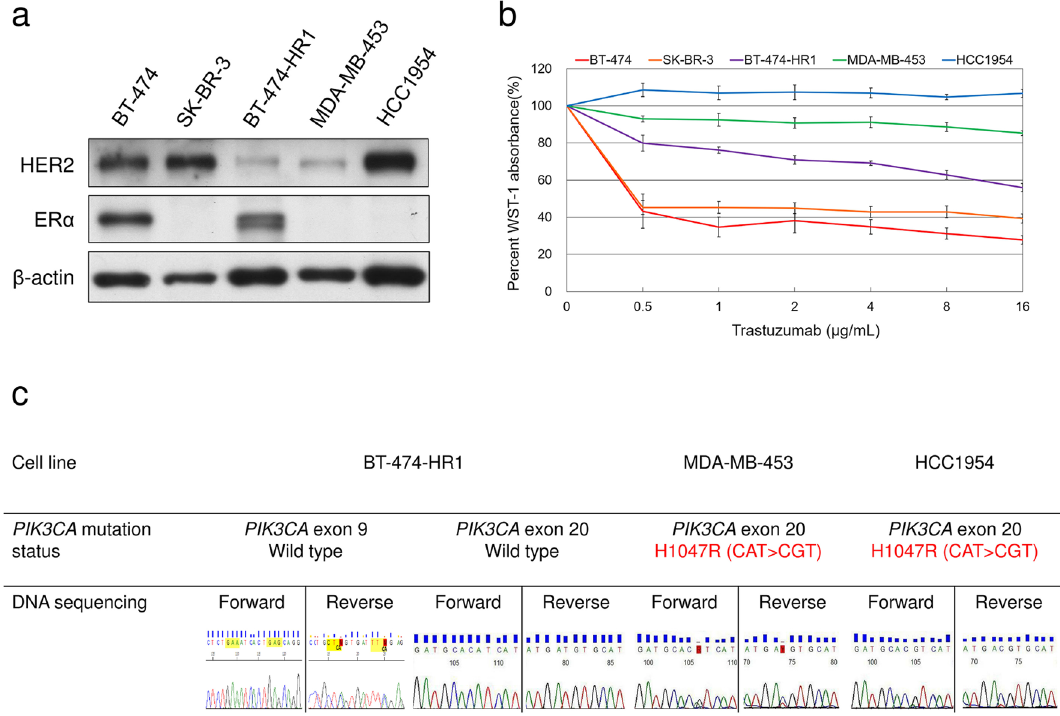
Figure 1. Characteristics of the five HER2-positive cell lines. ( a ) HER2 expression was confirmed through Western blot analysis in the five cell lines. Estrogen receptor expression was revealed in the BT-474 cell line compatible with its known feature. BT-474-HR1 cells derived from BT-474 cells retained estrogen receptor expression after selection from trastuzumab-resistant clones. ( b ) The growth inhibition status in the five cell lines was shown after treatment with different concentrations of trastuzumab. The percentage of WST-1 absorbance in the cells was determined 72 h after the incubation with trastuzumab (0.5–16 μg/mL) and then normalized to non-treated cells. Each plot indicates the mean value of at least three experiments, whereas error bars indicate the standard error of the mean. ( c ) The presence of PIK3CA gene mutation was evaluated in the three trastuzumab-resistant cell lines using direct exon 9 and 20